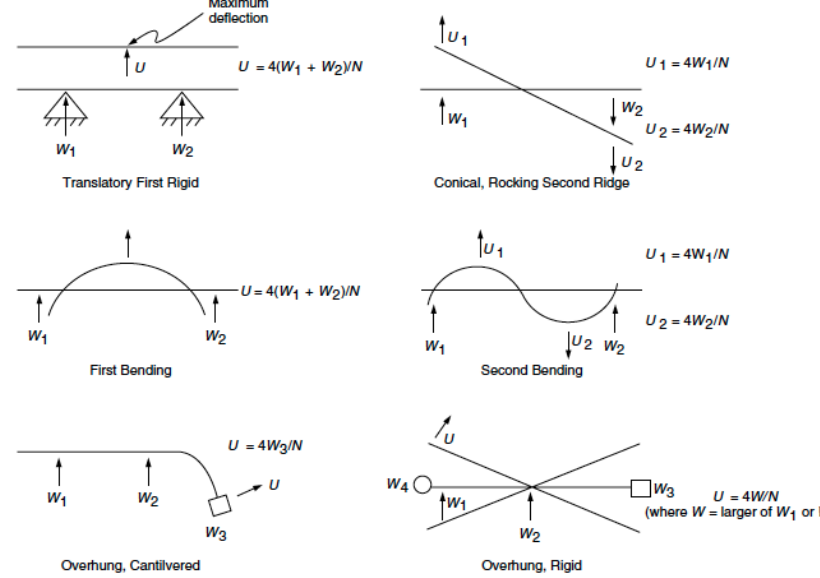
Figure 17. Unbalance values and locations as specified in API 617